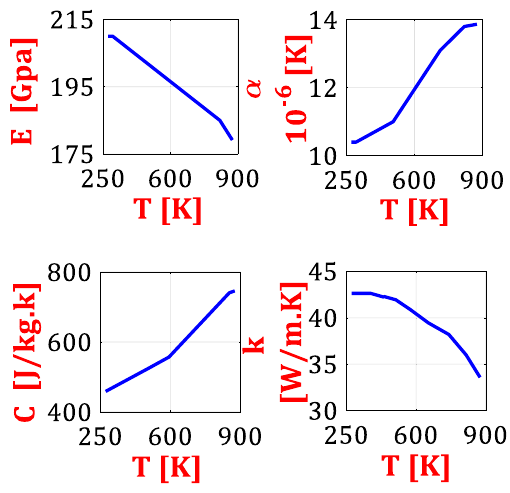
Fig. 8 Material properties of steel 4130 variations with temperature